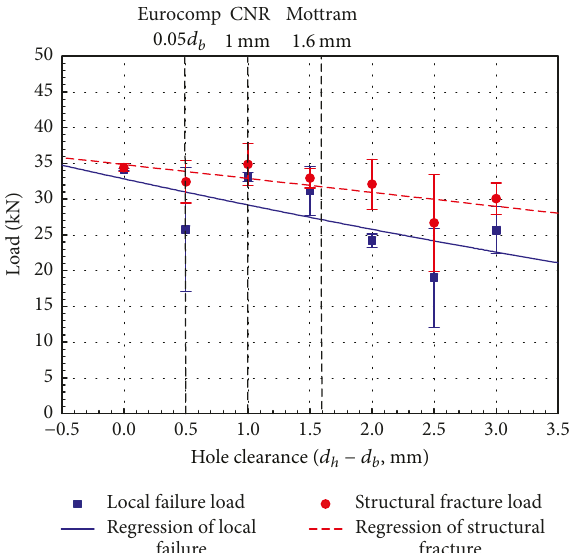
Figure 13: Relationship between load and bolt-hole clearance (specimen from I-shape-1).